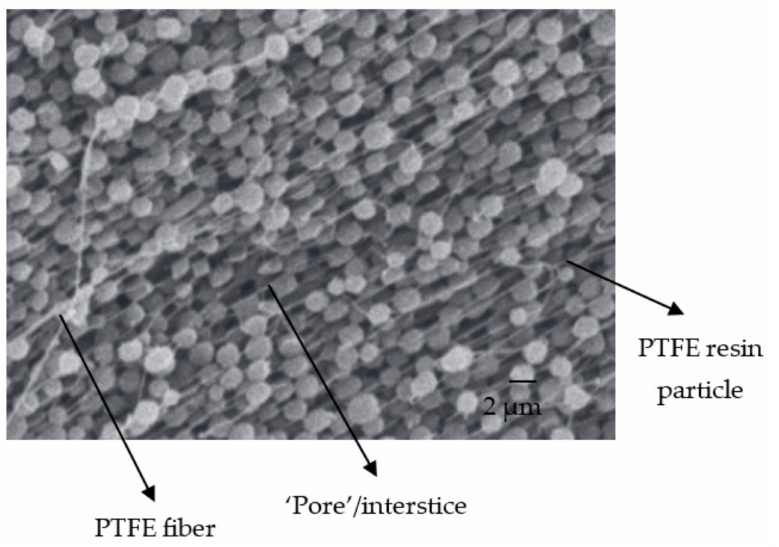
Figure 8. SEM image of fibrilled PTFE resin particles. Adapted from [53].